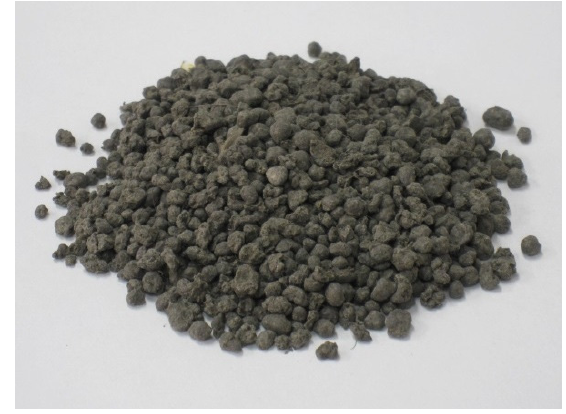
Figure 2. Sludge fuel.